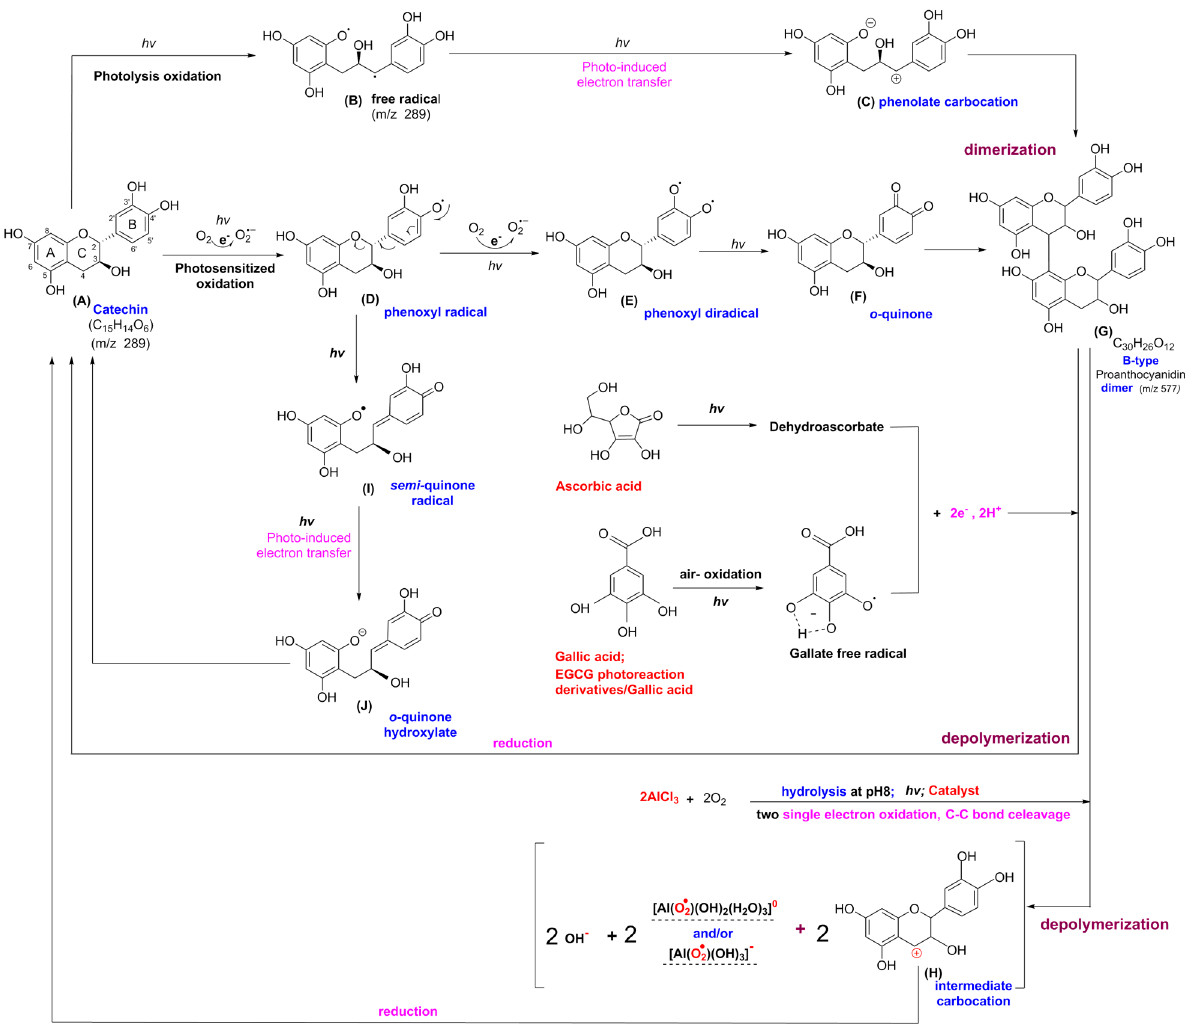
Figure 2. Proposed mechanism for the photolytic reaction of catechin treated with or without aluminum chloride, ascorbic acid, and gallic acid. Epigallocatechin gallate: EGCG. ( A ): catechin, ( B ): free radical at m/z 289, ( C ): catechin phenolate carbocation, ( D ): phenoxyl radical, ( E ): phenoxyl diradical, ( F ): o -quinone at m/z 287, ( G ): B-type proanthocyanidin, ( H ): catechin intermediate carbocation, ( I ): semi-quinone radical, and ( J ): o -quinone